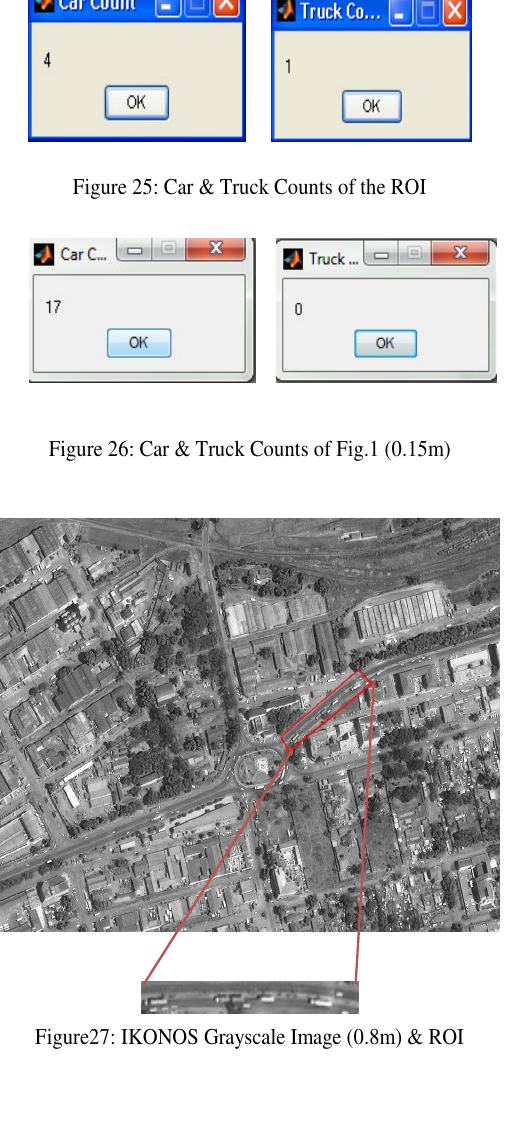
Figure 31: WorldView-2 Grayscale Image (0.46m) &